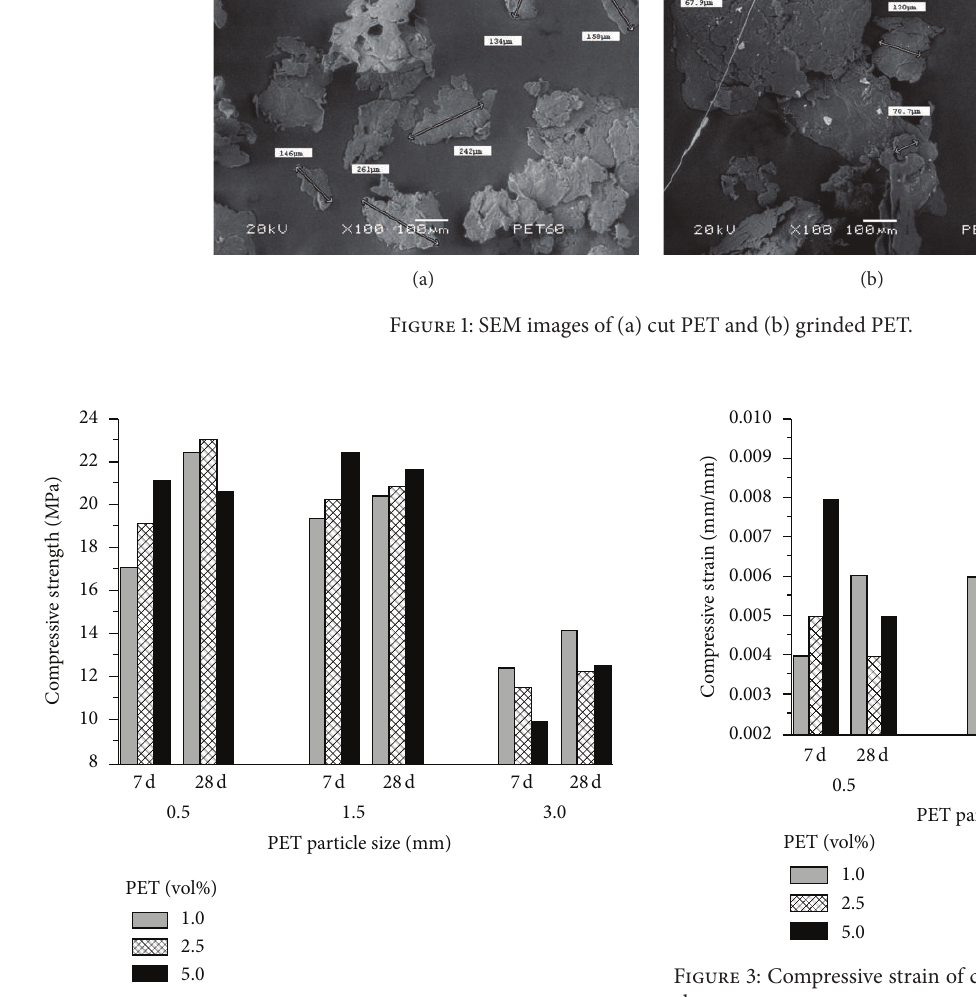
Figure 2: Compressive strength of concrete with recycled PET particles.